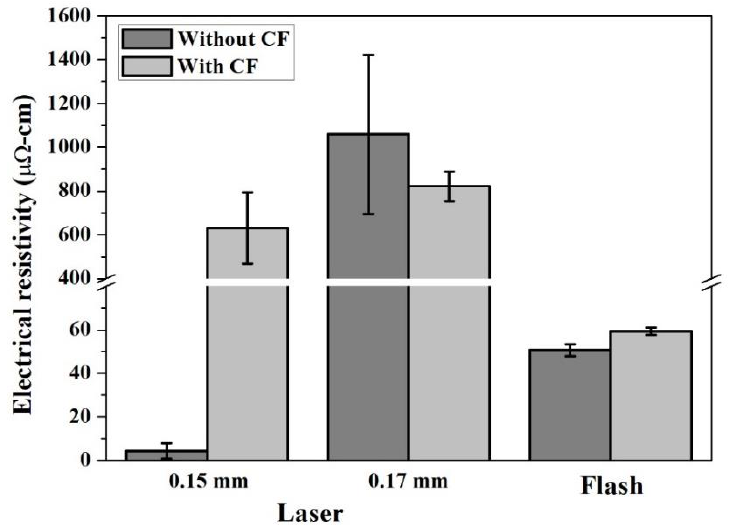
Figure 4. Electrical resistivity of sintered structure using laser and pulsed flash respectively (CF: copper formate).